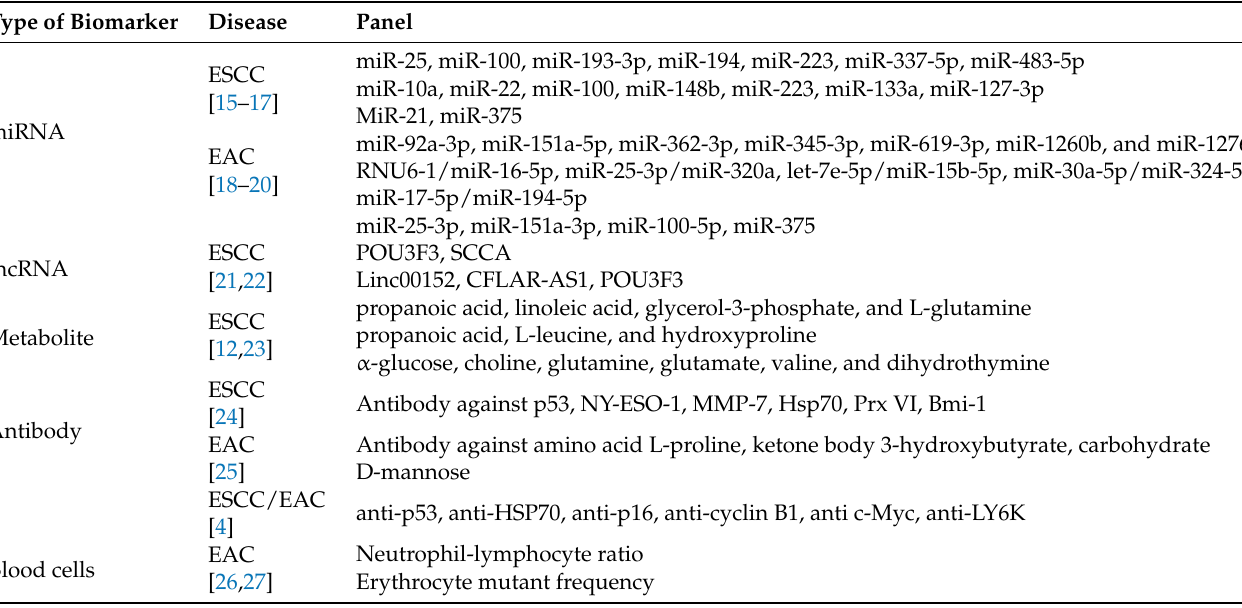
Table 1. Potential circulating blood molecules in the screening of esophageal cancer. Type of